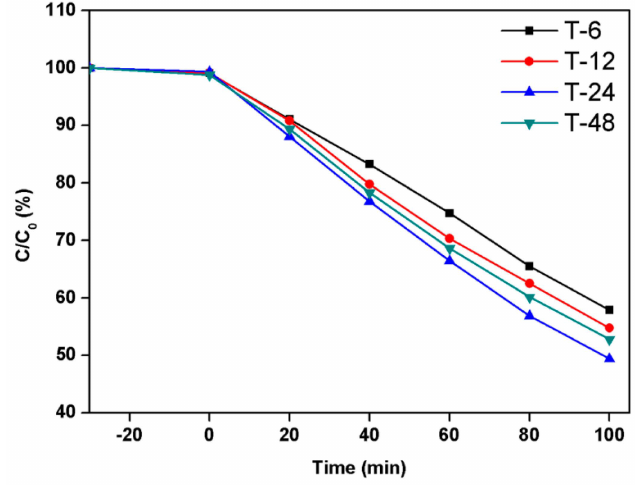
Figure 5. The photocatalytic activity of the TiO 2 hierarchical nanospheres prepared under di ff erent solvothermal reaction times: 6 h, 12 h, 24 h, and 48